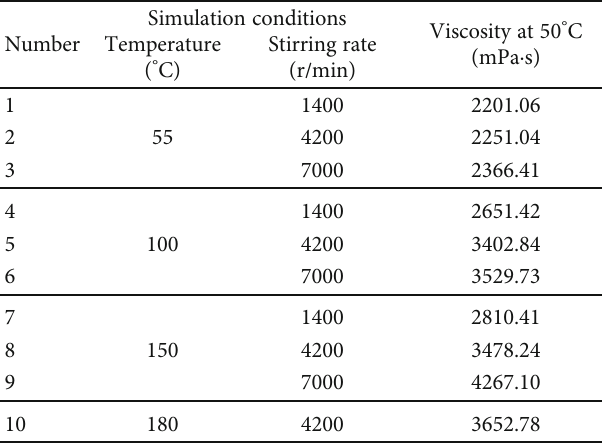
Figure 2: Images of water release from the emulsions at di ff erent temperatures and stirring rates. Table 3: The viscosity of heavy oil emulsions at 50 ° C at di ff erent temperatures and stirring rates.